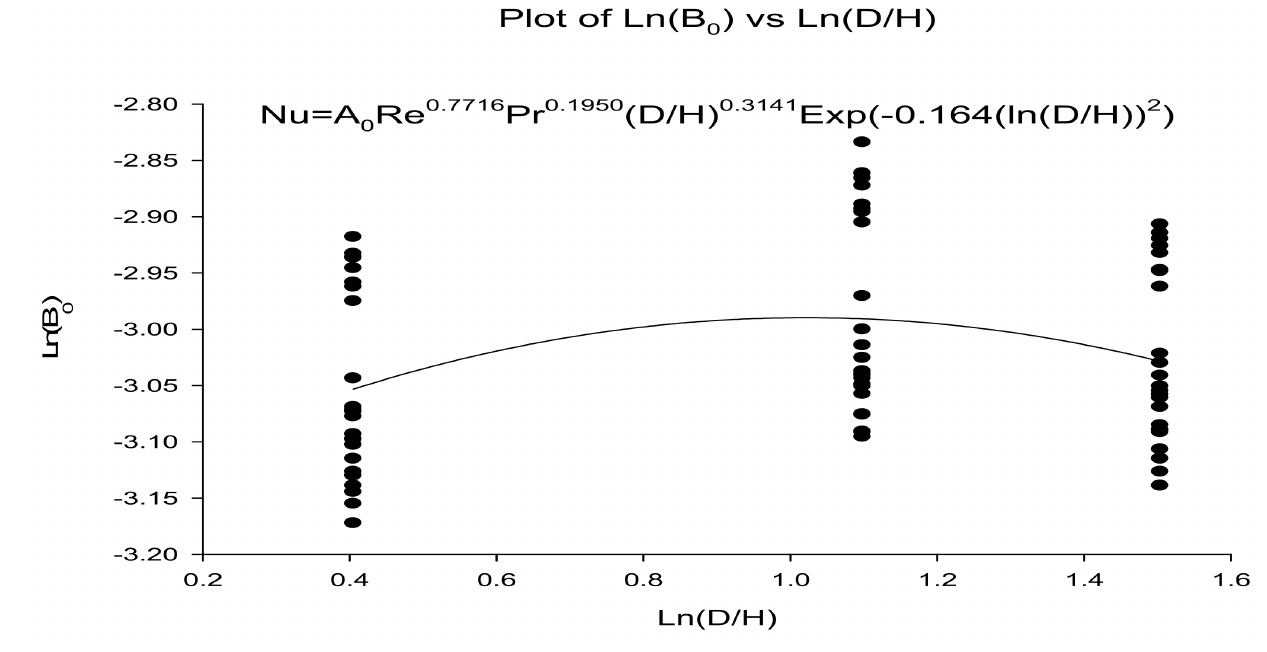
Figure 5. Experimental Variation of coefficient Bo and Depth ratio (D/H).